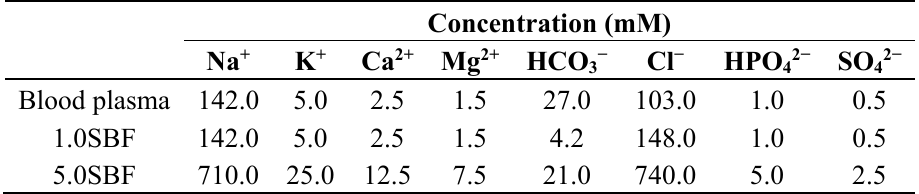
Table 2. Ion concentration of 1.0 Simulated Body Fluid (SBF) and 5.0 SBF solution in comparison with those of blood